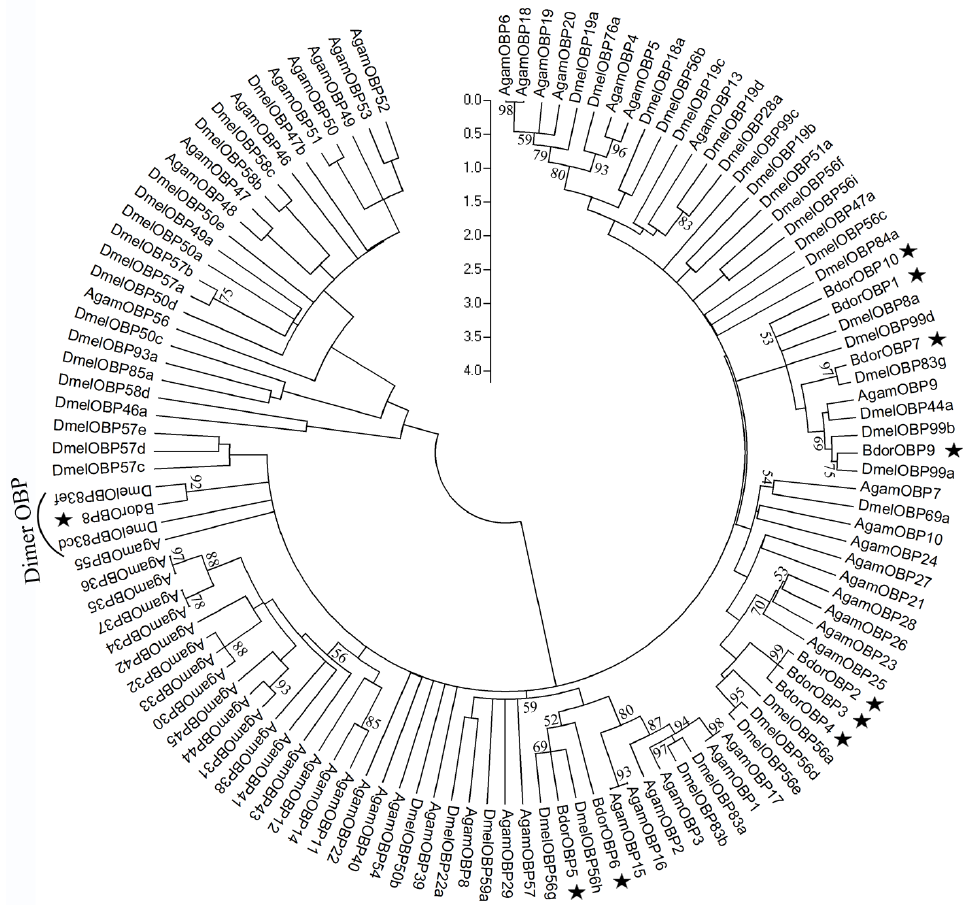
Figure 3. Phylogenetic analysis of BdorOBPs. The sequences used for the analysis included B. dorsalis and two other Dipteran species with full genome sequenced: D. melanogaster and A. gambiae . The highly divergent signal peptide sequences at the N -terminus were removed and the neighbor-joining tree was constructed using MEGA 4 with the pair-wise deletion option under the JTT empirical amino acid substitution model. Only bootstrap values above 50 were set to be